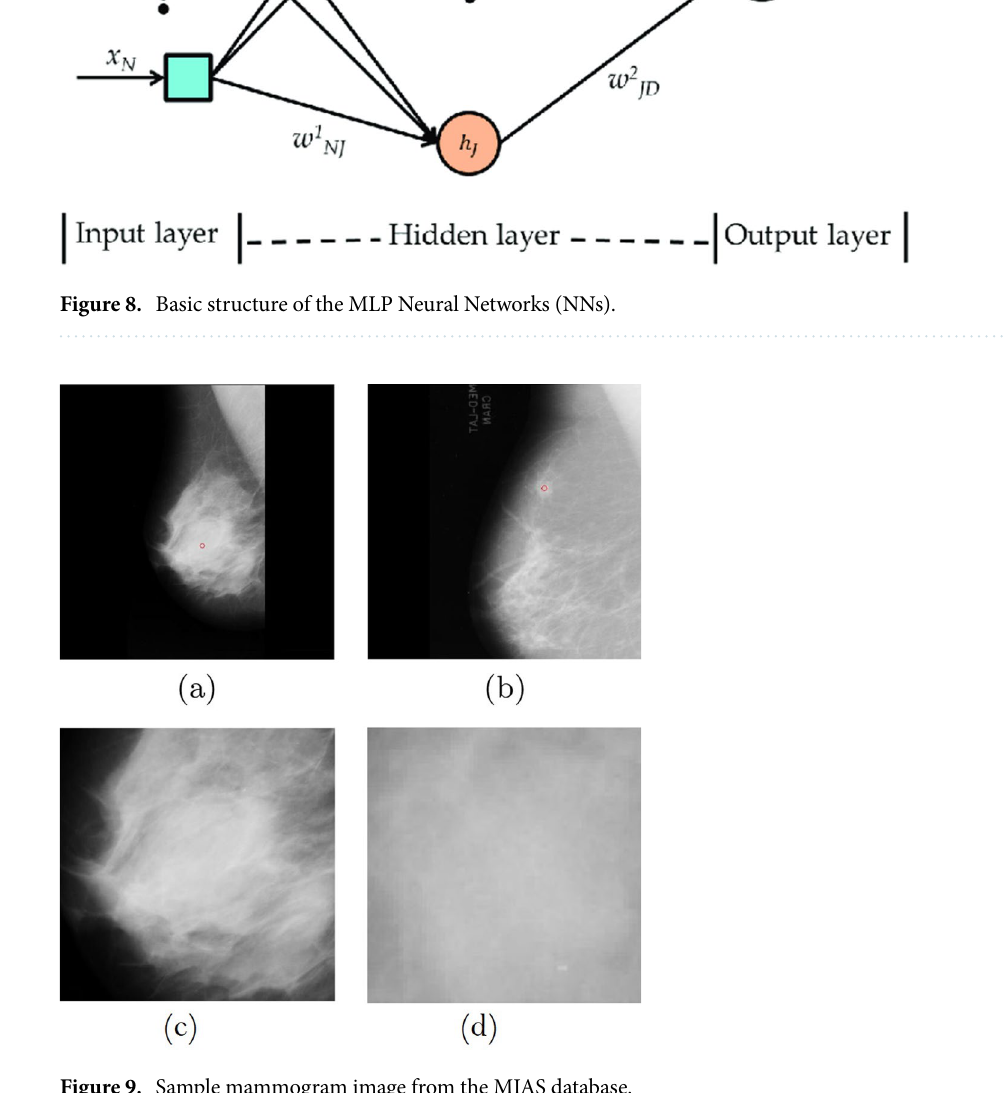
Figure 9. Sample mammogram image from the MIAS